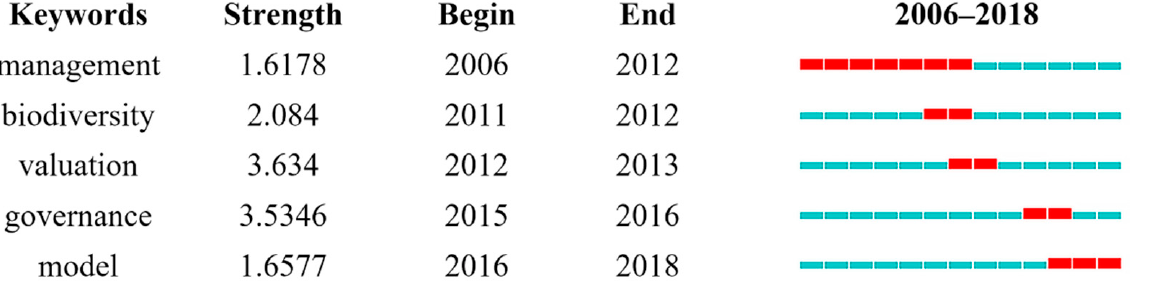
Figure 7. Top-five keywords with the strongest citation bursts. The blue represents the timeline, the red represents the time period in which the keyword appears, and thickness refers to highlighting.